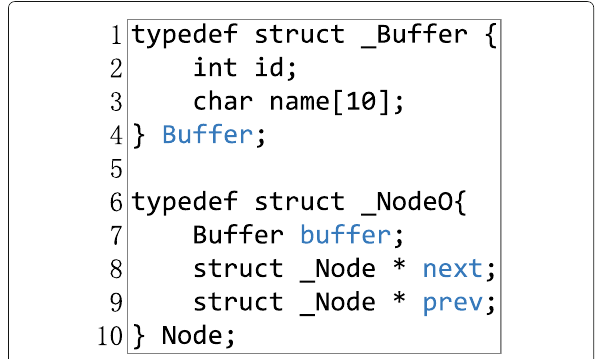
Fig. 6 A linked list node